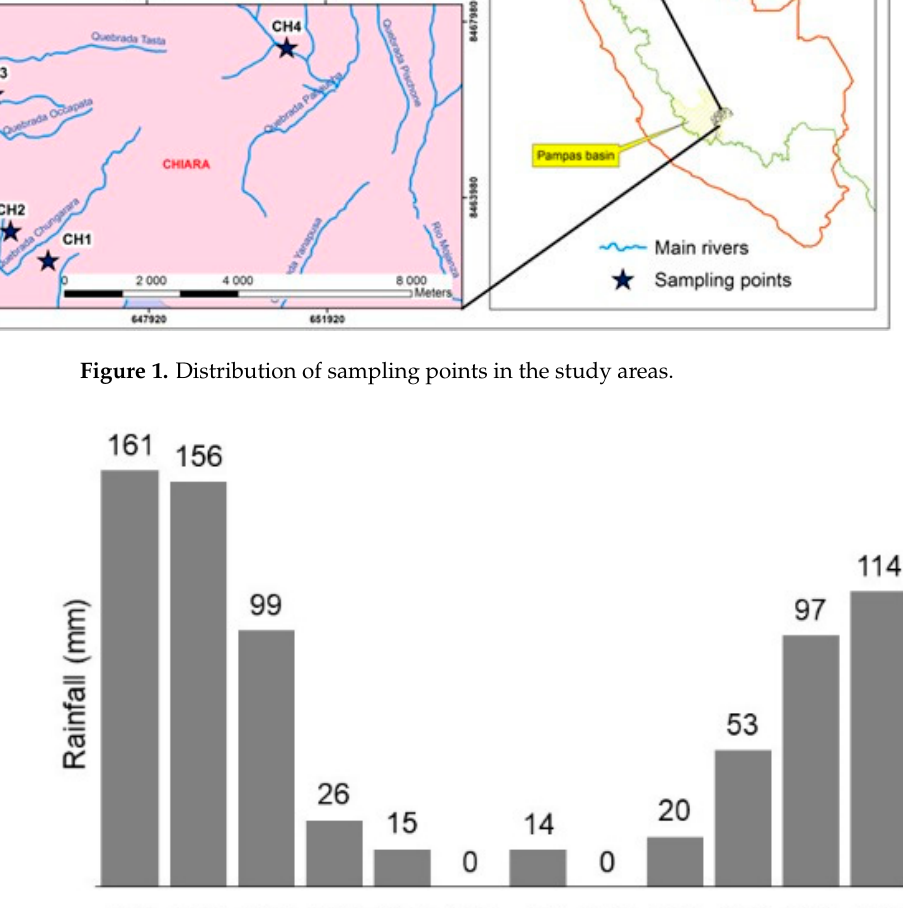
Figure 2. Precipitation between January and December 2019.